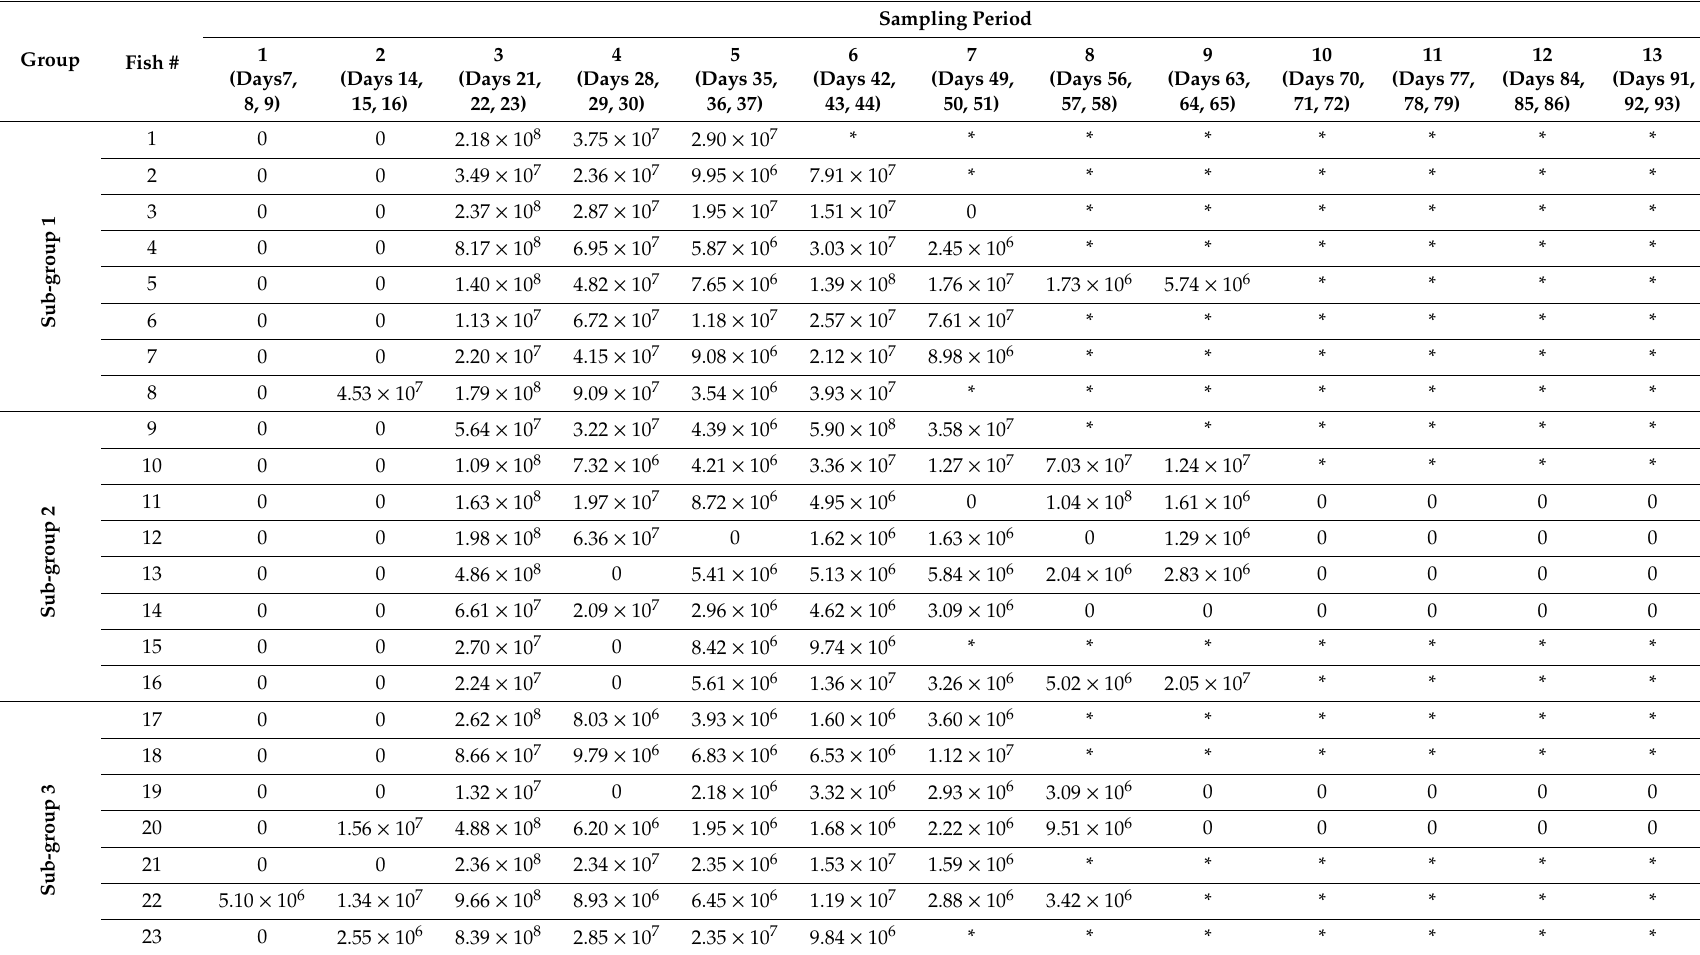
Table 1. Epizootic Epitheliotropic Disease virus (EEDV) DNA shedding by experimentally infected lake trout ( Salvelinus namaycush ).